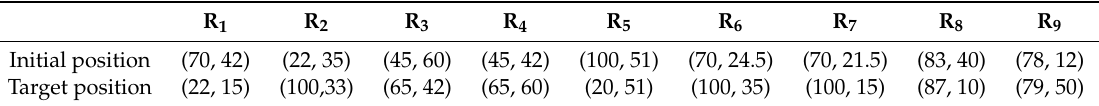
Table 7. Simulation